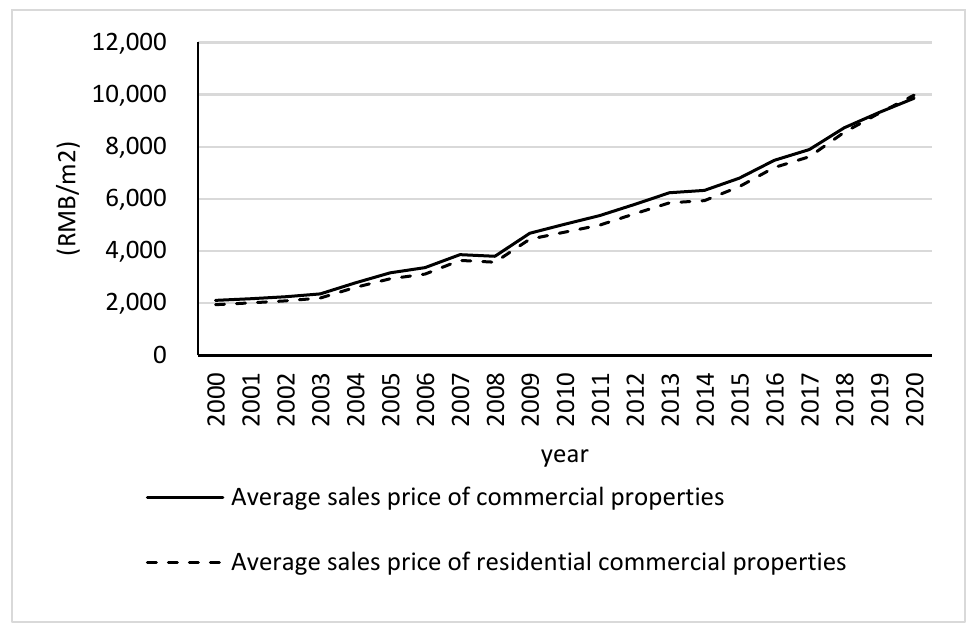
Figure 2. China’s annual house price trends.